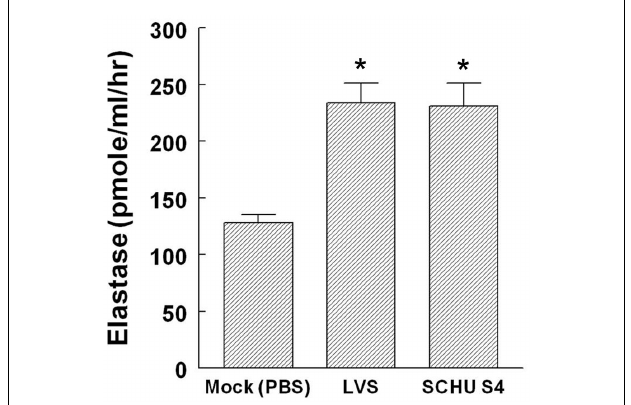
FIGURE 3 | Increased elastase activity in respiratory fluids following pulmonary F. tularensis challenge. Bronchoalveolar lavage fluid from mice (5-day post challenge, n = 5/group) from each group, i.e., Mock (PBS-treated) control, F. tularensis LVS, and F. tularensis (type A) SCHU S4